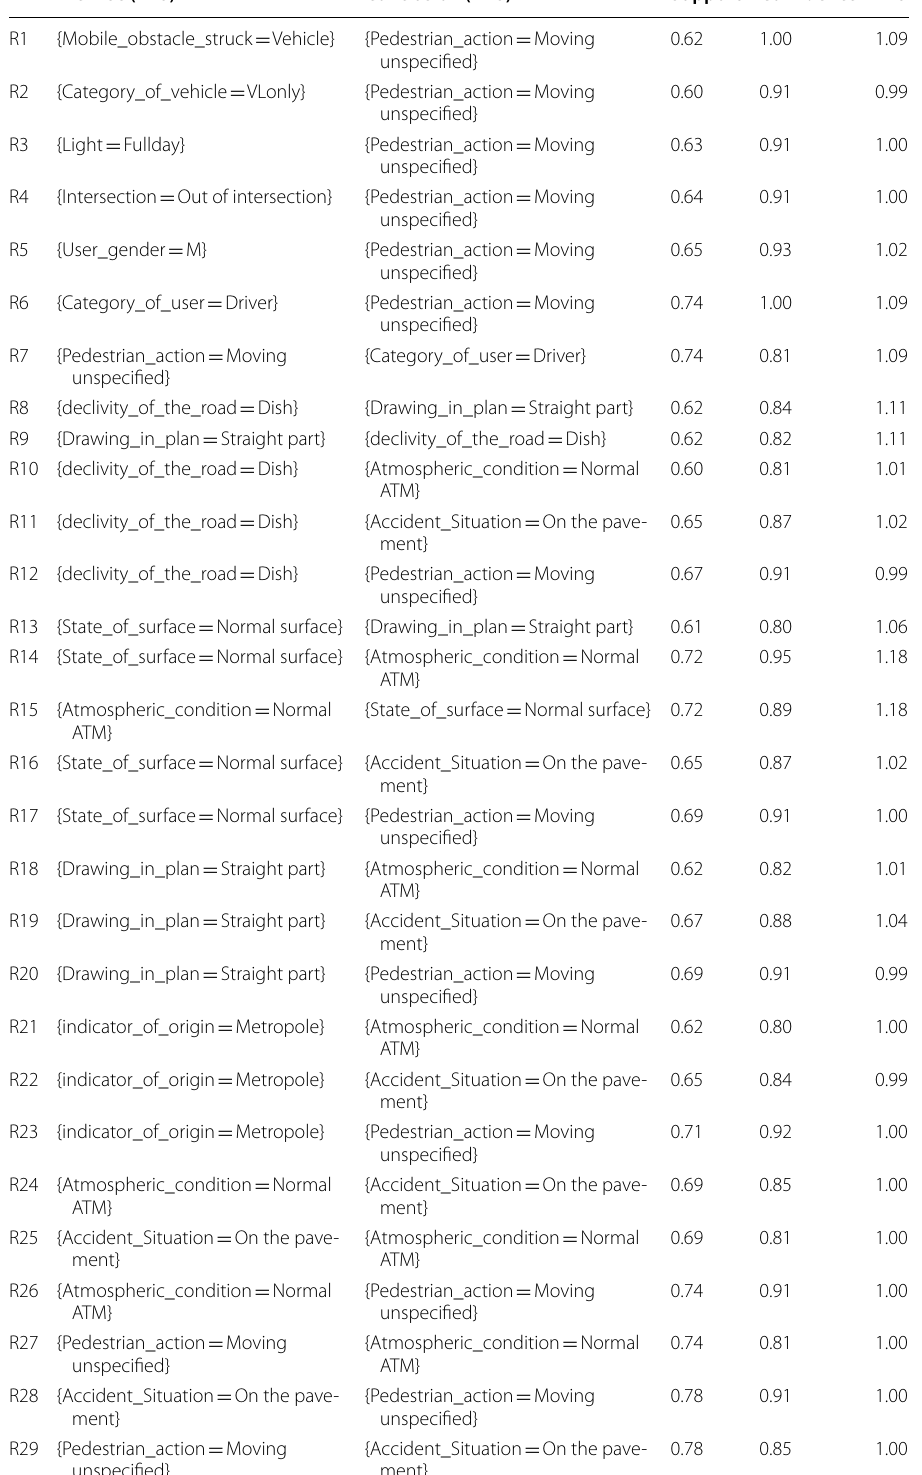
Table 4 The extracted association